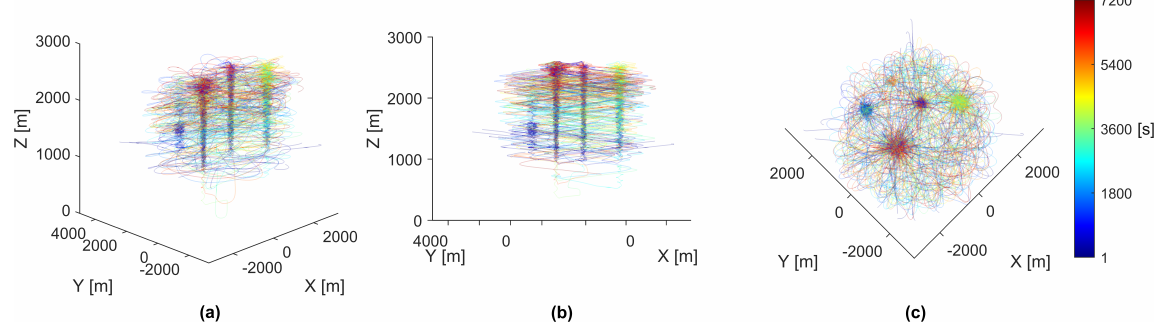
Figure 3. Paths of all 40 agents in a simulation. Each individual agent’s path was colored by time from start to finish measured in seconds, shown by the color-bar on the right side. All panels show different perspectives of the same data. ( a ) The paths rendered from an upper-corner perspective. ( b ) The paths rendered from a side-corner perspective. ( c ) The paths rendered from a top-down perspective.